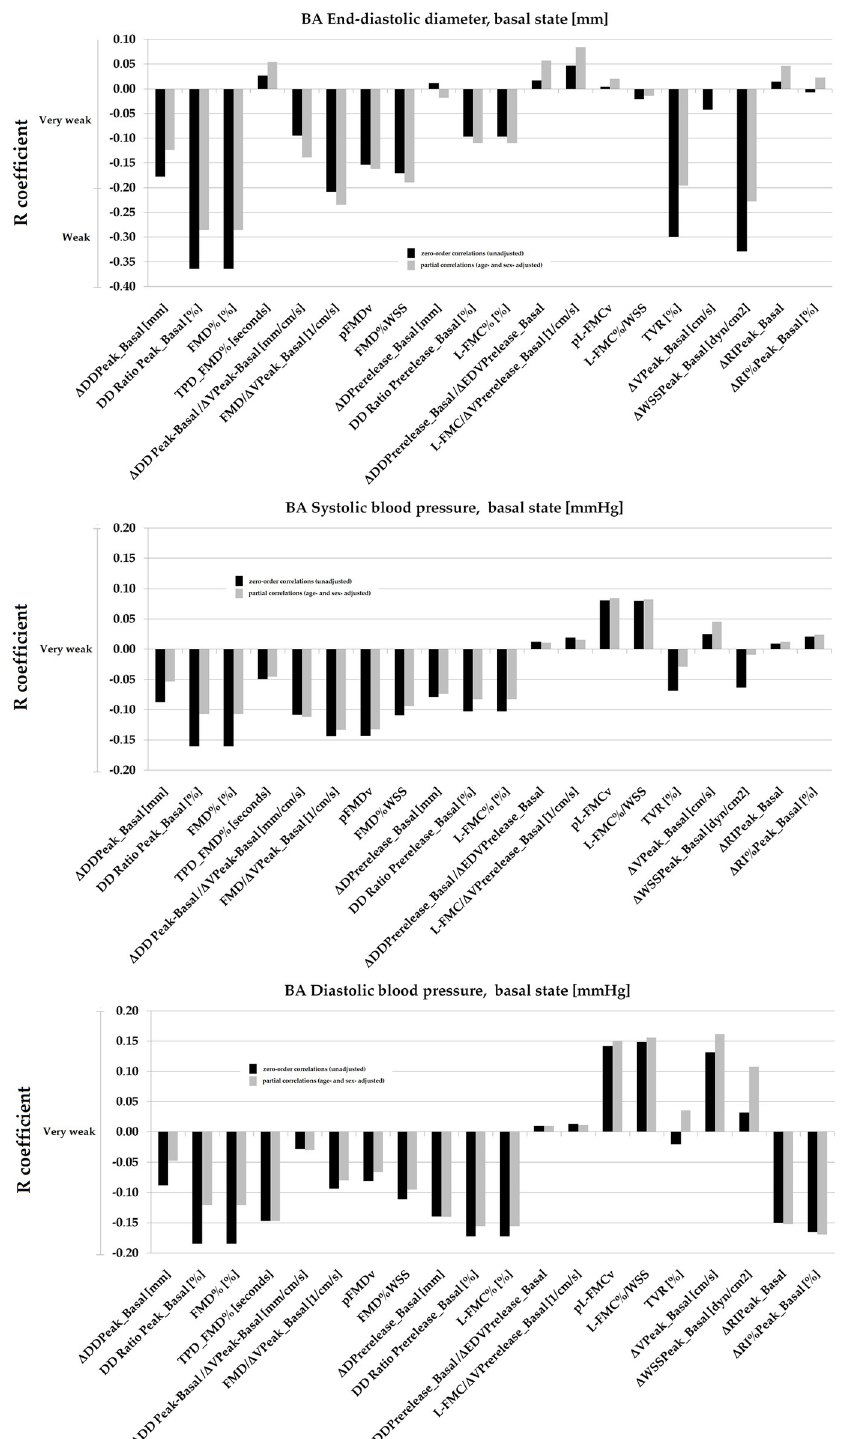
Fig 8. Associations (simple and partial correlations [adjustment for age and sex]) between vascular reactivity indexes and brachial artery (BA) end-diastolic diameter, and systolic and diastolic blood pressure.